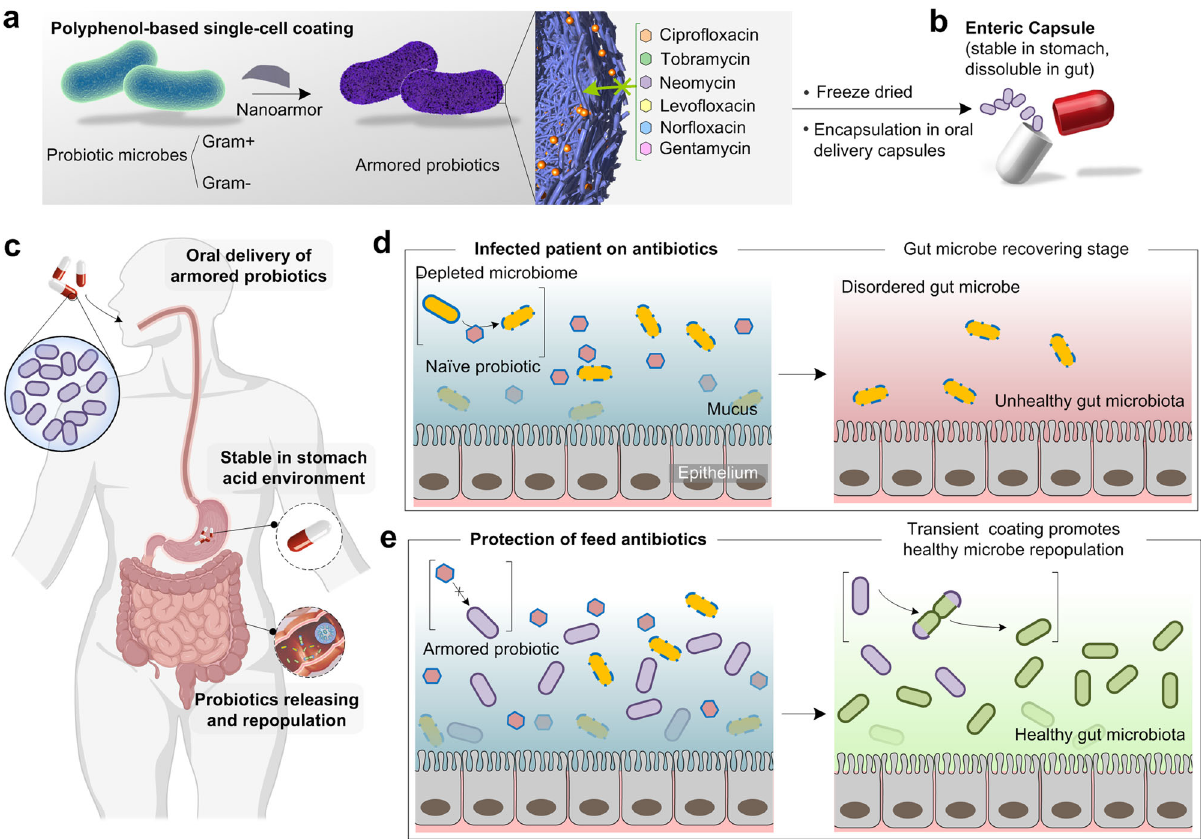
Fig. 1 Natural polyphenol-based single-cell coating (nanoarmor) for the protection of bacteria from antibiotics in the gastrointestinal (GI) tract. a The nanoarmor enables a rapid and highly biocompatible single-cell encapsulation that protects from a wide range of antibiotics with different molecular structures and properties. b Armored probiotic bacteria can be freeze-dried and fi lled into enteric capsules designed for oral delivery. c The enteric capsule remains intact during the low pH of gastric transit and releases the armored probiotics in the gut. d The poor speci fi city of antibiotics normally depletes healthy commensals in the gut and hinders probiotic treatments. e The nanoarmor provides a safe and transient coating to the bene fi cial bacteria from antibiotics, facilitating healthy microbe